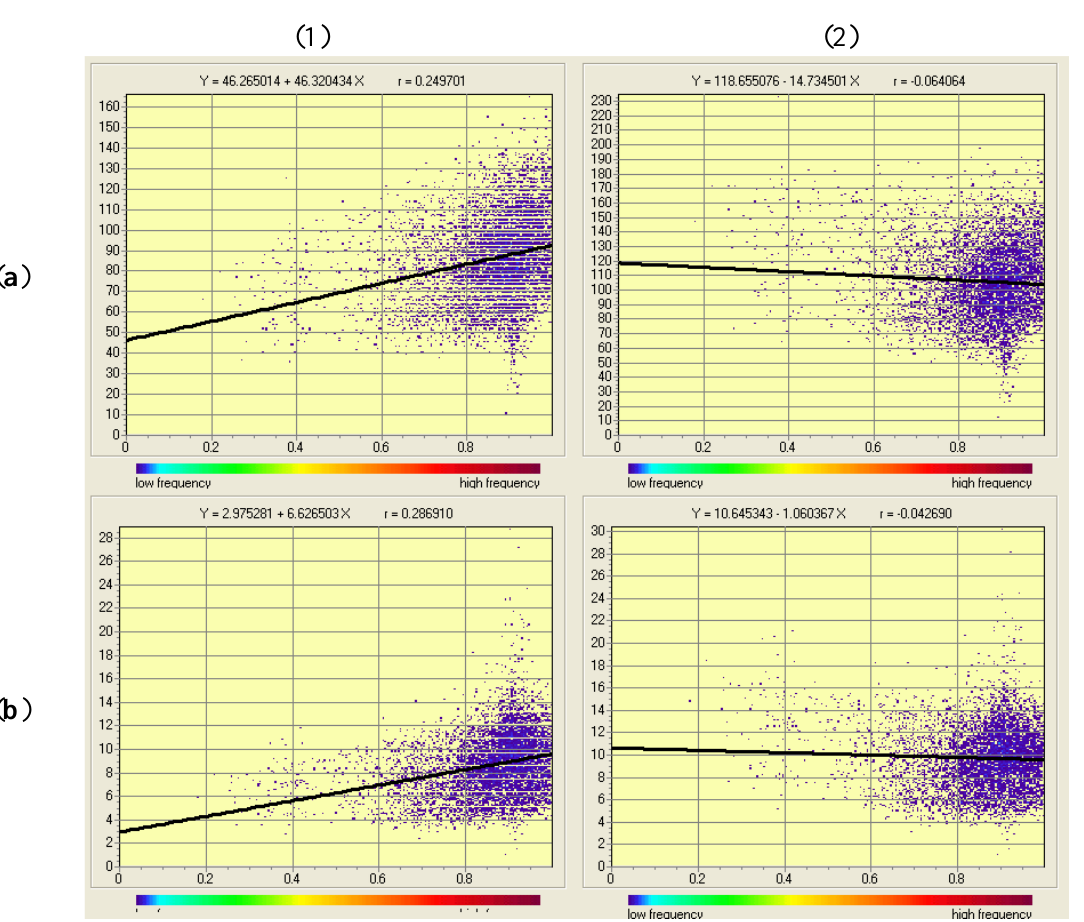
Figure 5. Same as in Figure 4, but for ( a ) band 4, ( b ) band 5 and ( c ) band 7, for the noncorrected (1) and for the corrected radiance data (2),